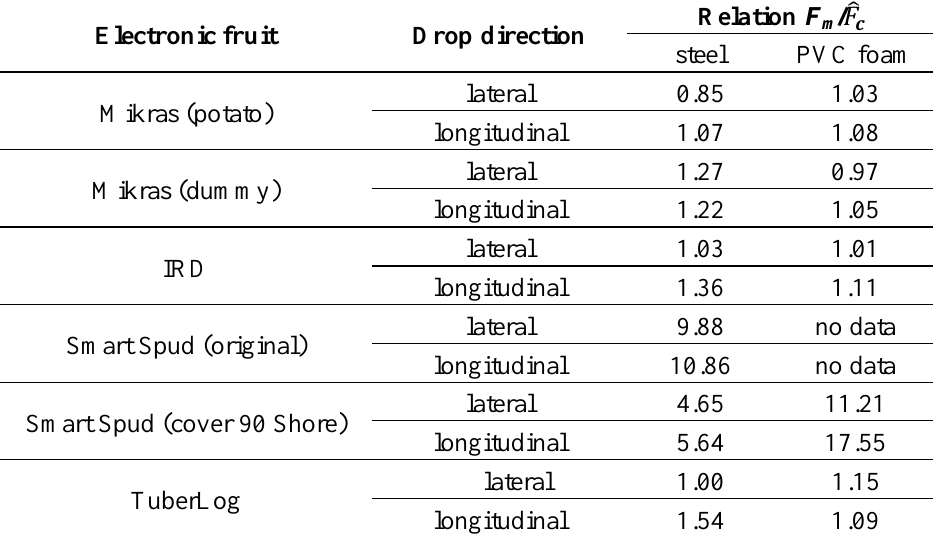
Table 2. Relation of measured peak force with drop simulator ( F ( ) for the falls from 10 cm height onto steel or PVC